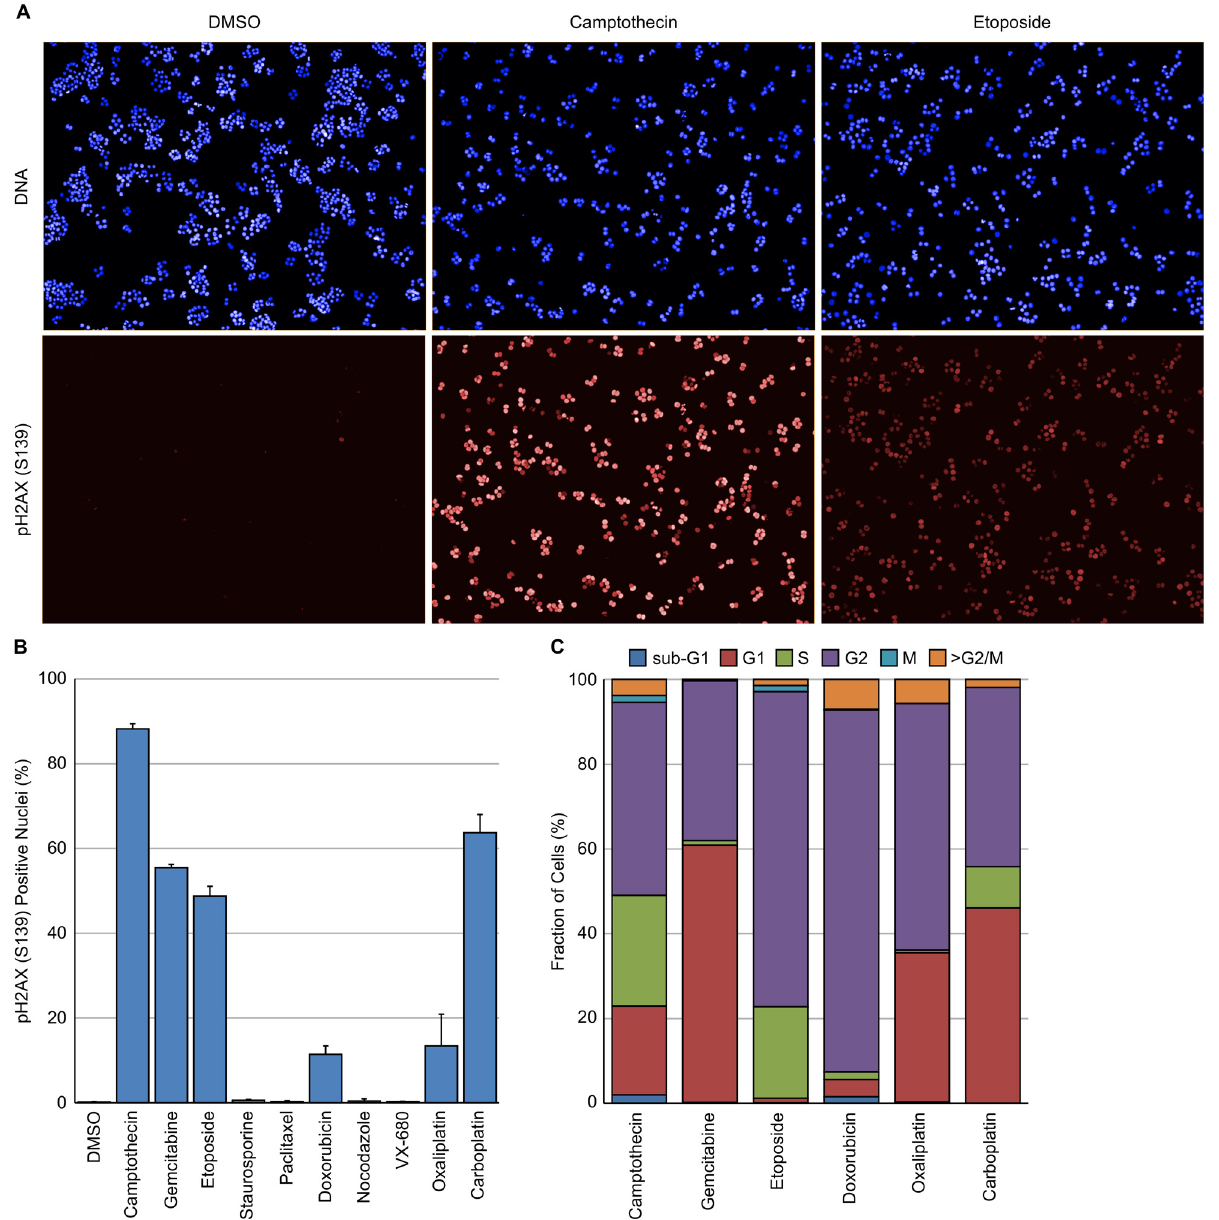
Fig 4. Determination of cell cycle phase of γ H2AX positive cells following treatment with a cytotoxic DNA damaging agent. HT29 cells were treated with the indicated compound for 24 hour and then fixed and stained with Hoechst 33342, EdU, pHH3 (S10) and pH2AX (S139). (A) Example images from HT29 cells treated with DMSO, camptothecin or etoposide demonstrating the presence of pH2AX (S139) positive ( γ H2AX) nuclei. (B) Quantification of the fraction of γ H2AX positive nuclei following treatment with the various agents. (C) Cell cycle distribution of γ H2AX positive nuclei following multiparametric analysis. Values are the average of 6 technical replicates ±